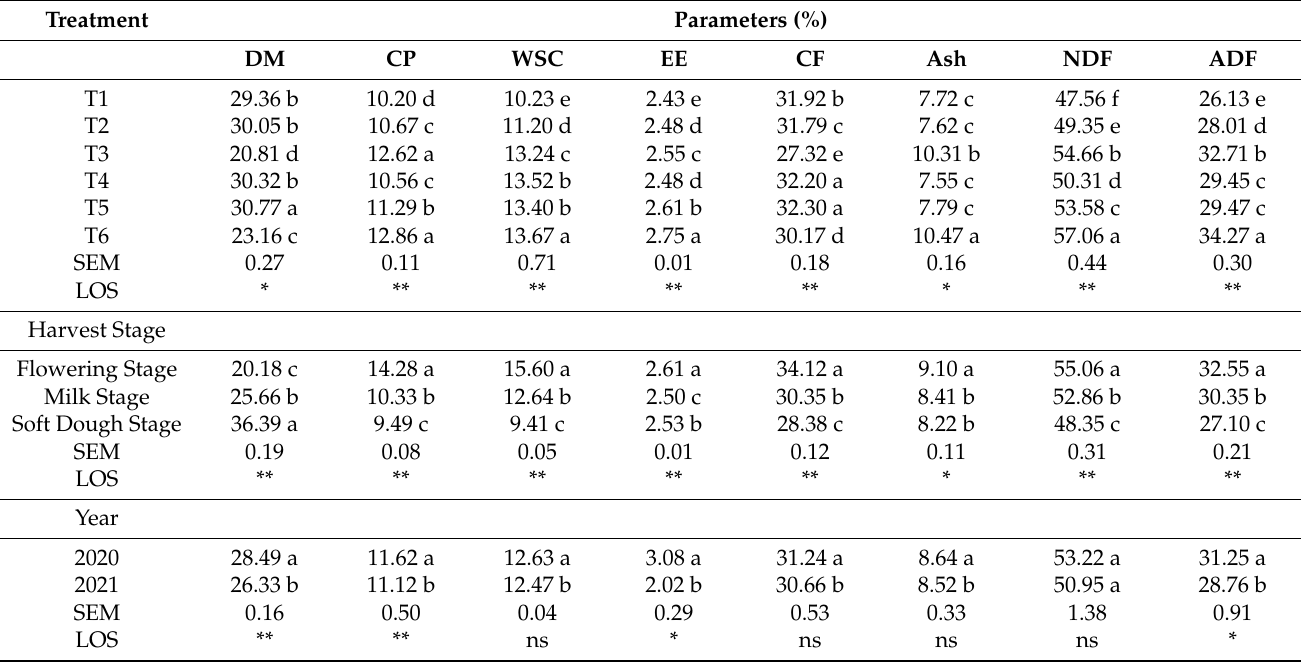
Table 2. Proximate compositions of forage were conducted by wheat and ryegrass sole-cropped and mixed with alfalfa harvested at different maturity stages